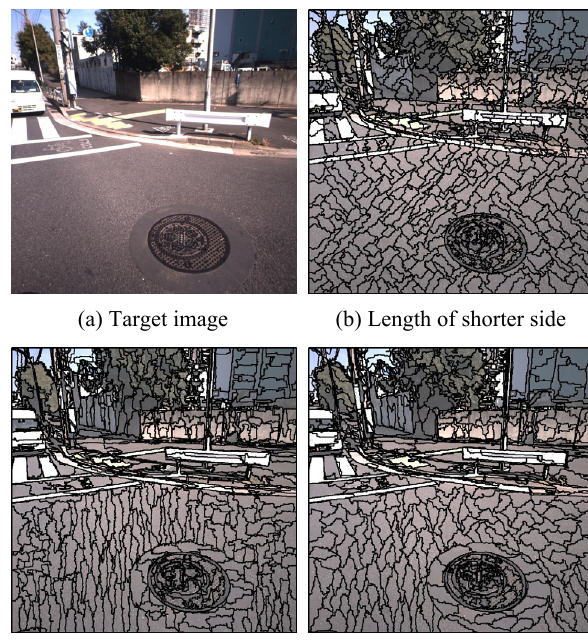
Figure 4. Segmentation results by the different definitions for extent of objects